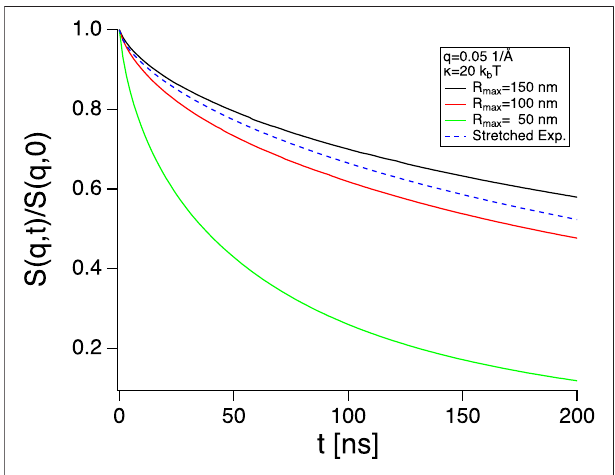
FIGURE 7 | S ( q , t ) calculated using Eq. 10 with different R max (full lines) and Eq. 1 (dashed blue line, using κ not ~ κ ) using parameters indicated in the graph. The maximum length scale clearly has an effect on S ( q , t ).